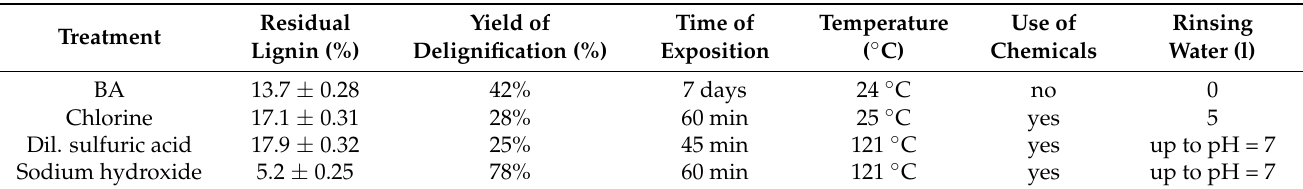
Table 2. Characteristics of delignification and bio-delignification treatments carried out on GW samples (BA = Bjerkandera adusta